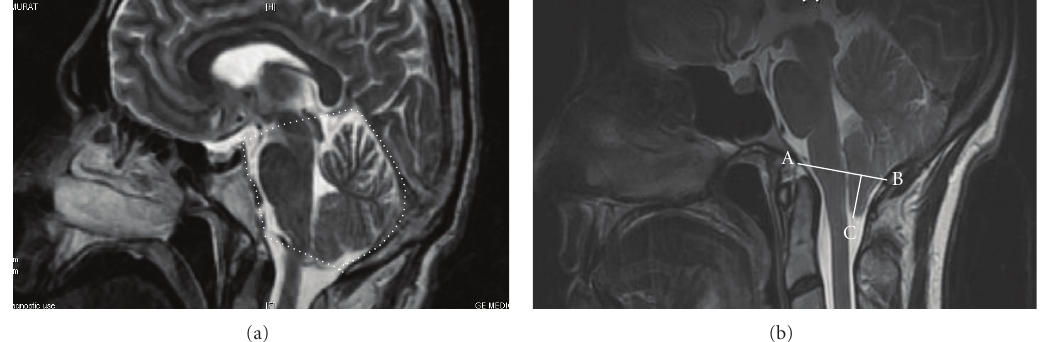
Figure 1: Brain MR midsagittal T2 demonstrating the posterior cranial fossa boundaries (a), the measurement of herniated tonsils from sagittal images with A: basion, B: opisthion, and C: degree of tonsillar herniation measured as the length perpendicular from C to AB